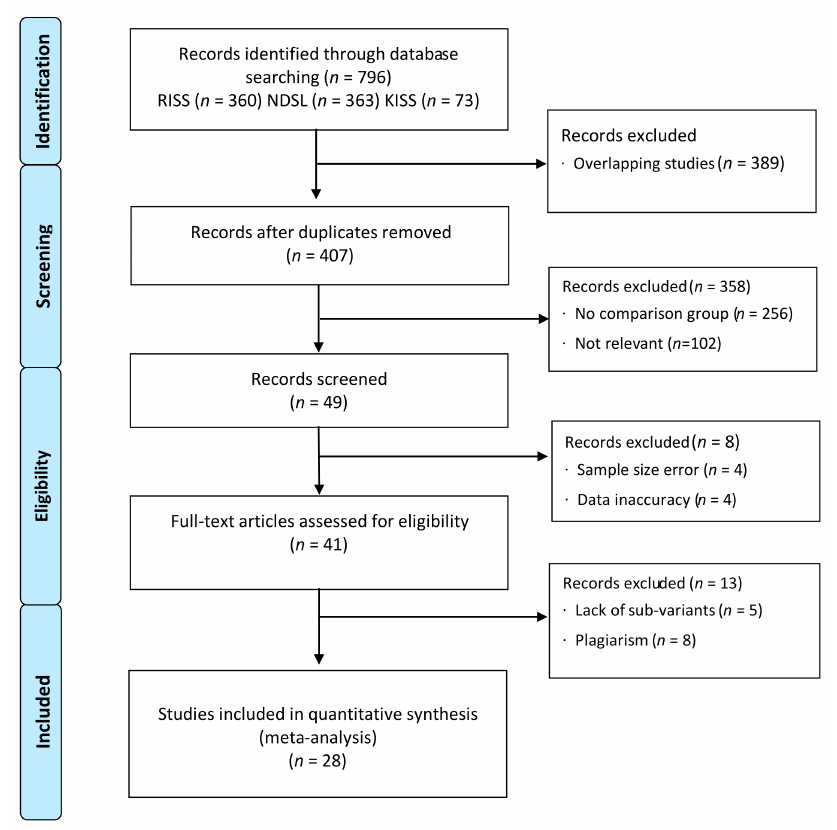
Figure 1. Flow chart of article screening